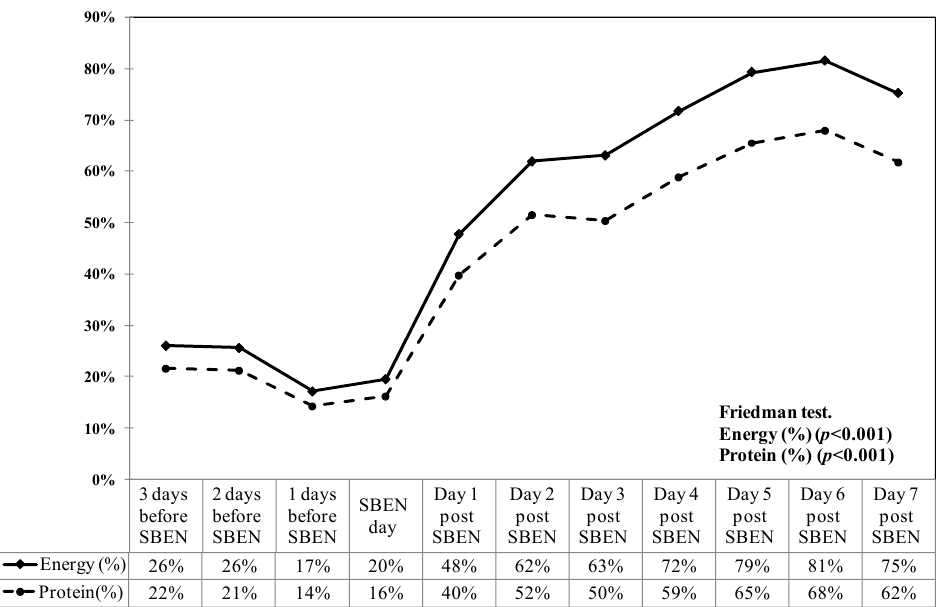
Figure 1. Achievement rate of energy and protein intake before and after small bowel enteral nutrition (SBEN) ( n = 49). Table 2. Nutritional achievement of malnourished critically ill patients before and 3 days after SBEN in malnourished critically ill patients.